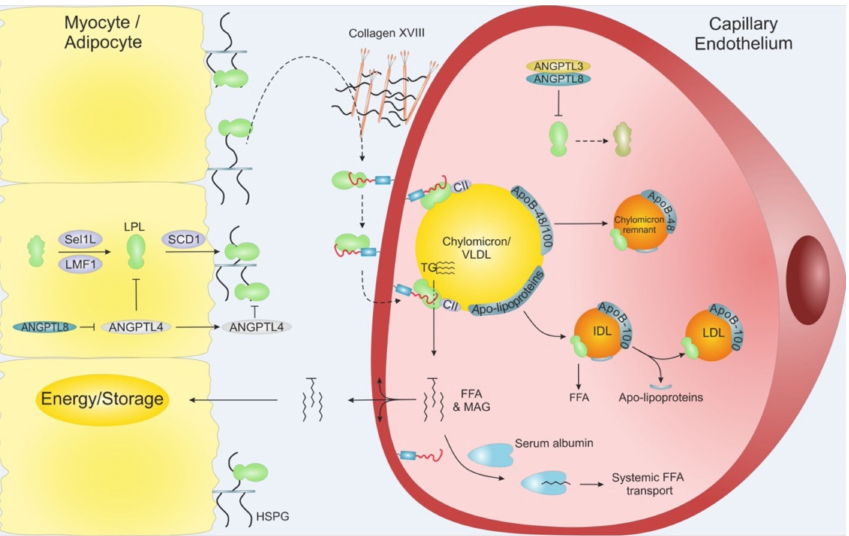
Figure 3. Schematic overview of LPL translocation. LPL is secreted from adipose tissue and myocytes from skeletal muscles and heart. Intracellular LPL folding and secretion is assisted by LMF1, Sel1L and SCD1. After secretion, active LPL is bound to cell surface HSPG before being translocated to GPIHBP1, potentially via Collagen XVIII. GPIHBP1 captures LPL in the subendothelial space and mediates LPL trancytosis across the capillary endothelium, into the lumen. Within the